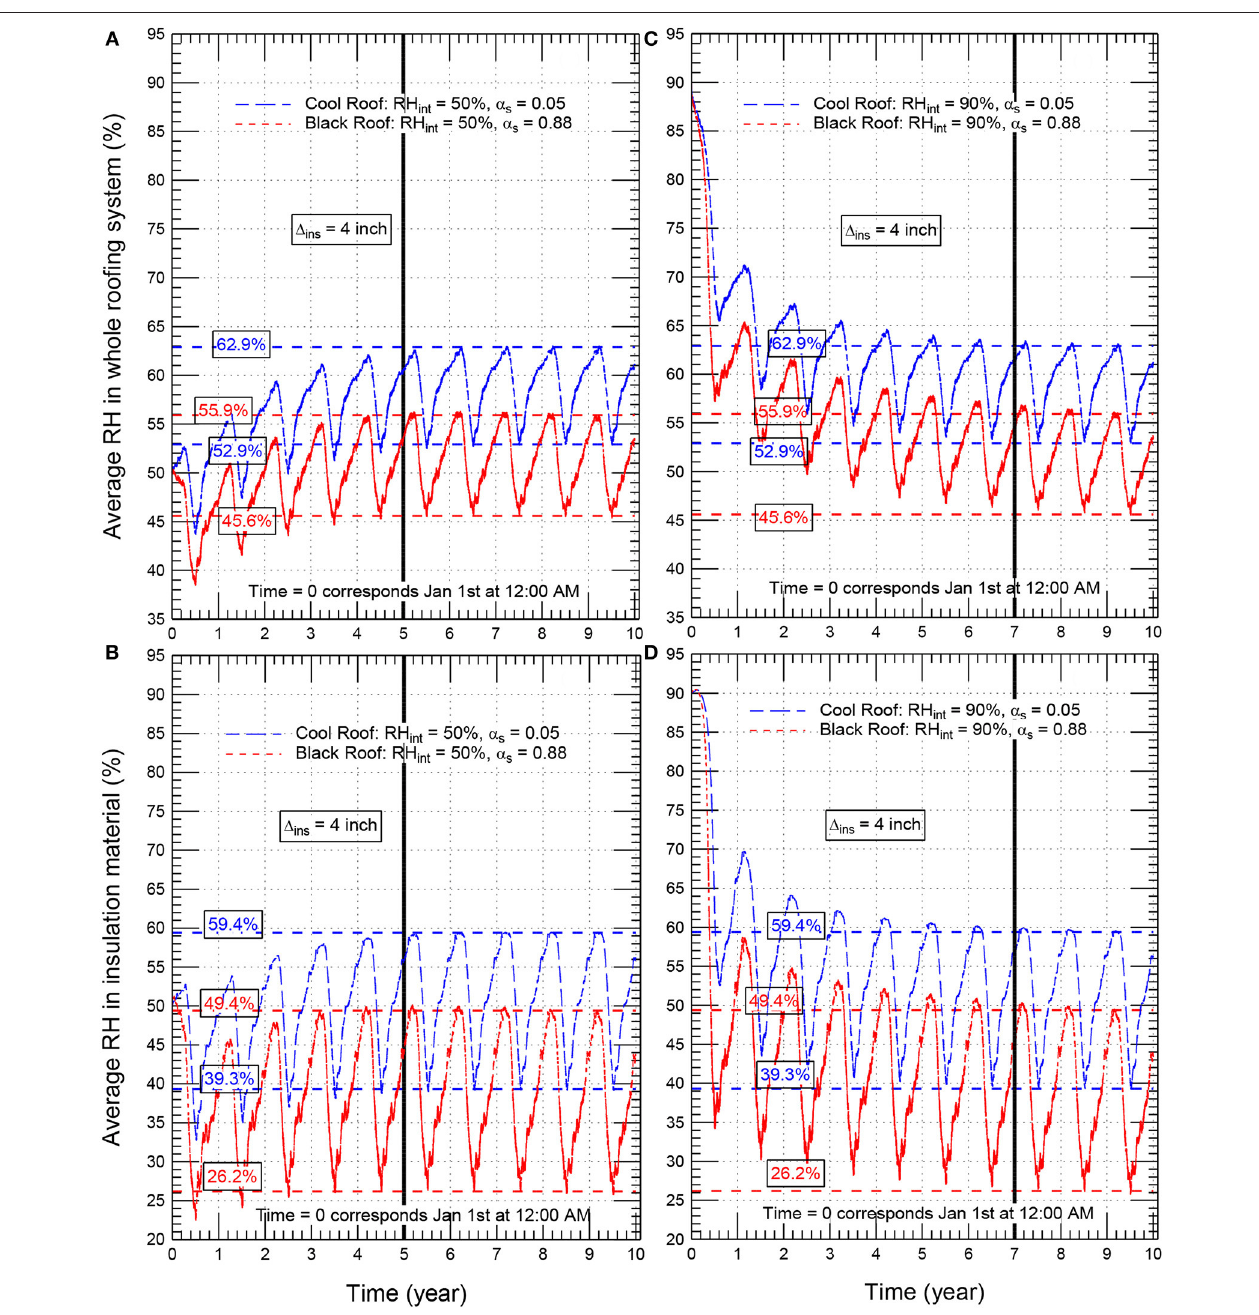
FIGURE 7 | Average hourly relative humidity in the whole roof (A,C) and the insulation material (B,D) of conventional/black roof ( α s = 0.88) and cool roof ( α s = 0.05) for 1 ins = 102mm (4.0